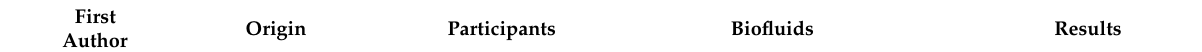
Table 4. Summary of case-control studies assessing ceramide levels in patients with